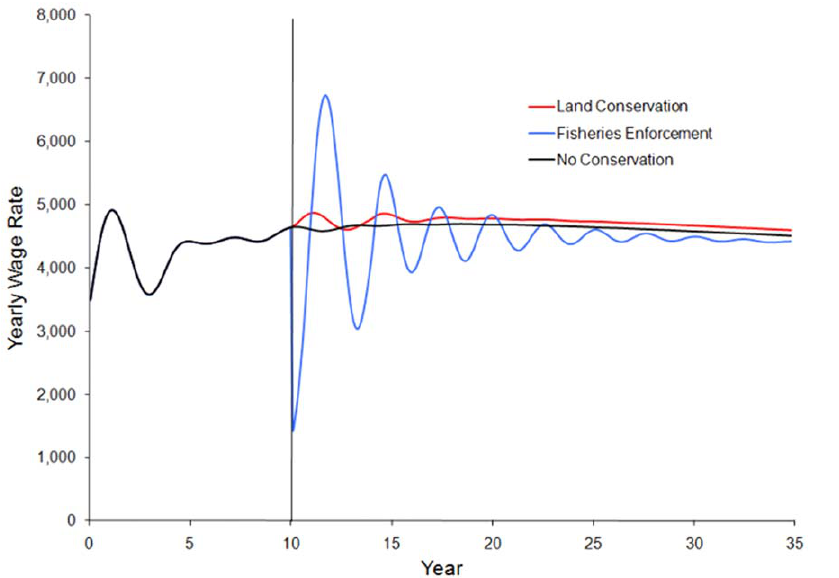
Figure 6. Wage rate with declining fish stock. Conservation strategies are implemented at year 10, denoted by the vertical line. Fisheries enforcement leads to a decline in the present value of all future income for workers, and also creates instability in wage rates. Land conservation leads to an increase in the wage rate. The initial instability in the model is due to the implementation of increased ability to catch fish. Due to the recruitment delay of our fish stock, it takes several years for these dynamics to stabilize.